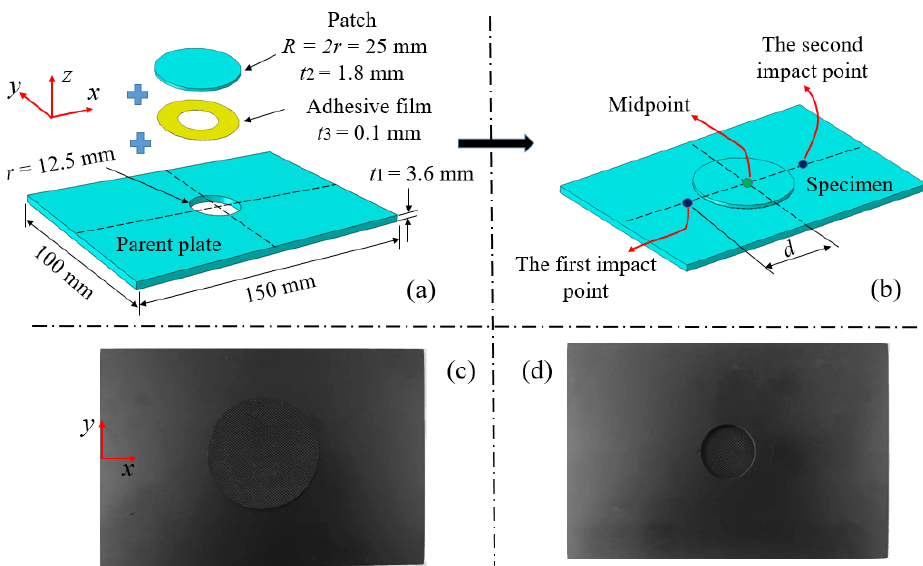
Figure 1. Geometry information of ( a ) the parent plate and ( b ) the geometry configuration of the patch-repaired specimen and a photograph of ( c , d ) the patch-repaired specimen .